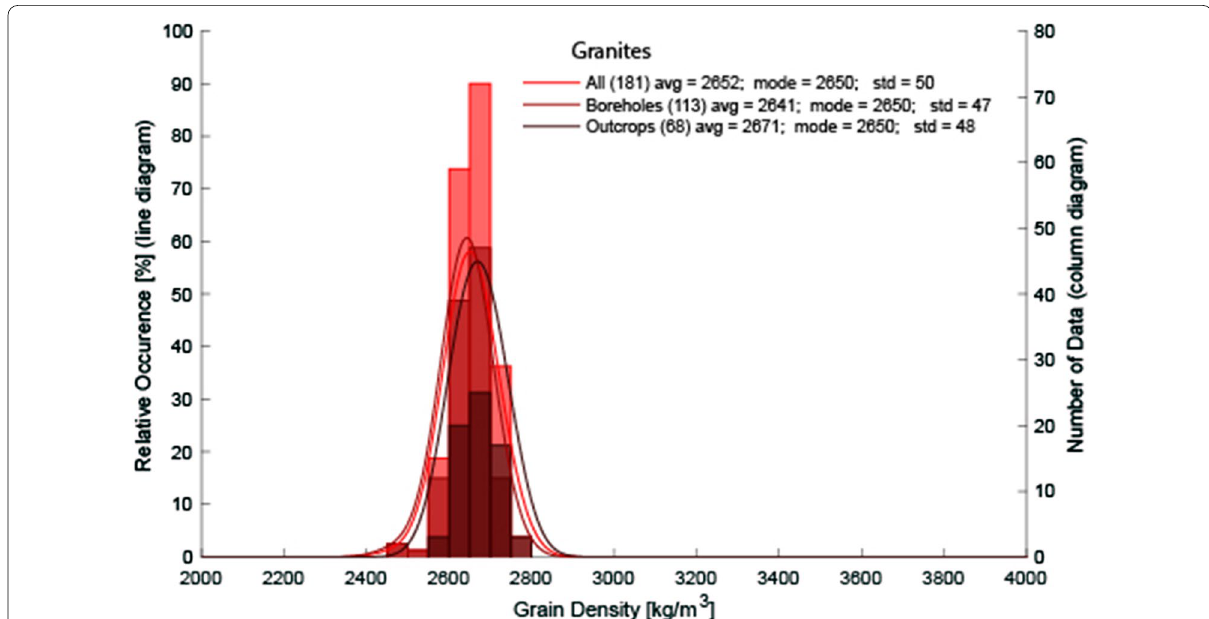
Fig. 7 Measured density values distribution for granites. The data distribution of grain density has been a valid instrument to determine and validate the criteria we adopted in grouping. The displayed distributions clearly justify merging the surface data with data at depth (borehole) for this lithology group. Numbers in parenthesis represent the total number of data. The figure provides a visual comparison of a histogram and a kernel distribution generated from the density data for granites from boreholes, outcrops and all together. Histograms refer to the number of data (on the right vertical axis) falling in a specific densities range, here in steps of 50 g/cm 3 . For example, in the case of granites from boreholes, out of 113 density data available, 47 fall in the range from 2650 to 2700 g/cm 3 . Solid curves represent the kernel smoothing function calculated over the density data population and representing the relative occurrence of density values in % (left axis). In granites from boreholes the value of density with max probability (here 60%) is 2641 kg/m